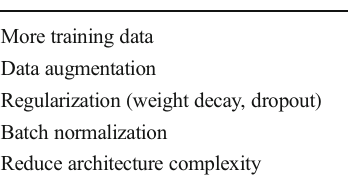
How to mitigate